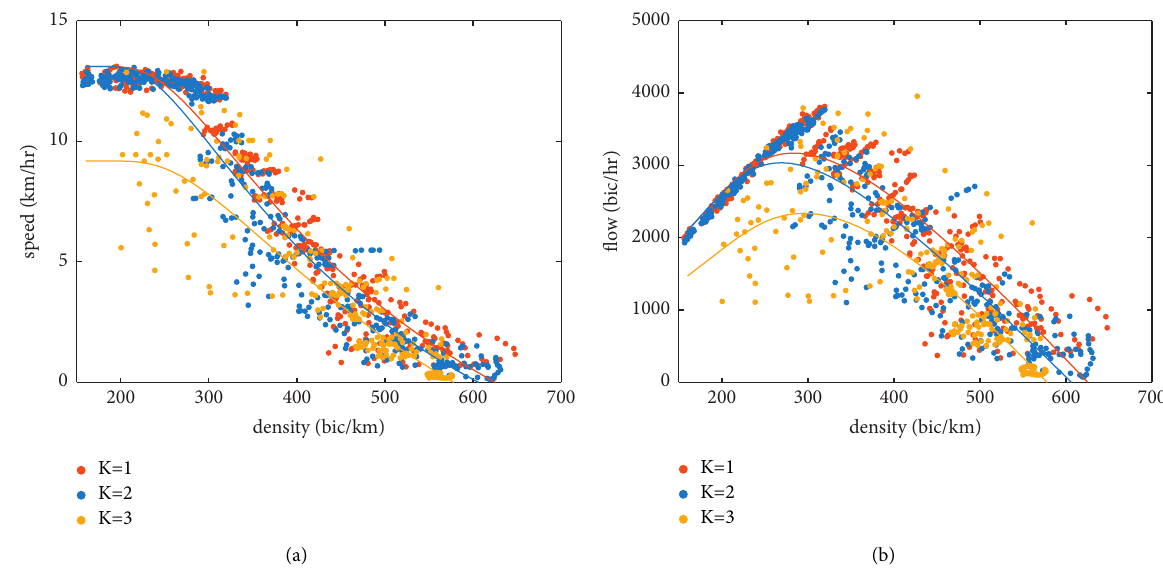
Figure 10: Fundamental diagrams under shoulder group behavior with different group sizes. (a) Speed vs. density. (b) Flow vs.